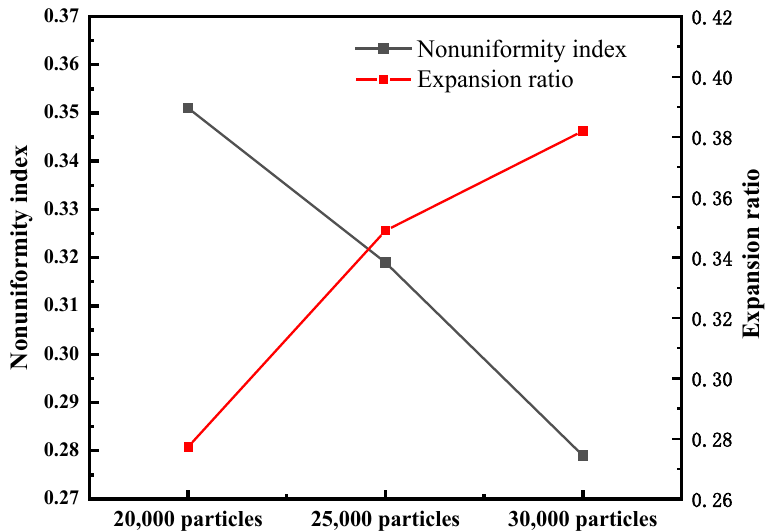
Figure 11. Nonuniformity index and expansion ratio of different initial bed heights.